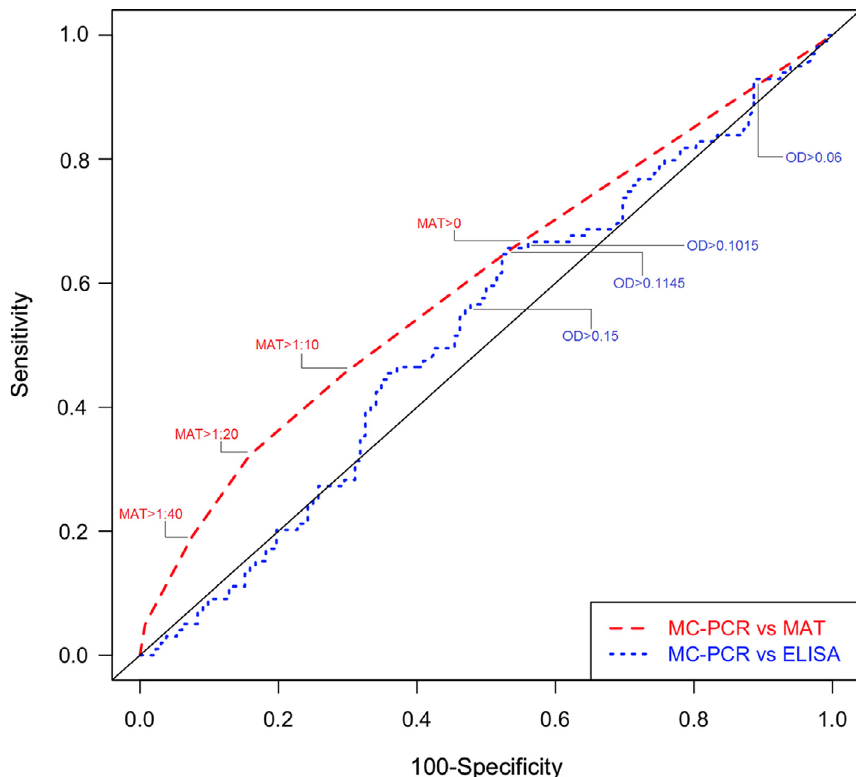
Figure 1. Receiver operating characteristics (ROC) analysis of ELISA and MAT vs. MC-PCR in meat juice